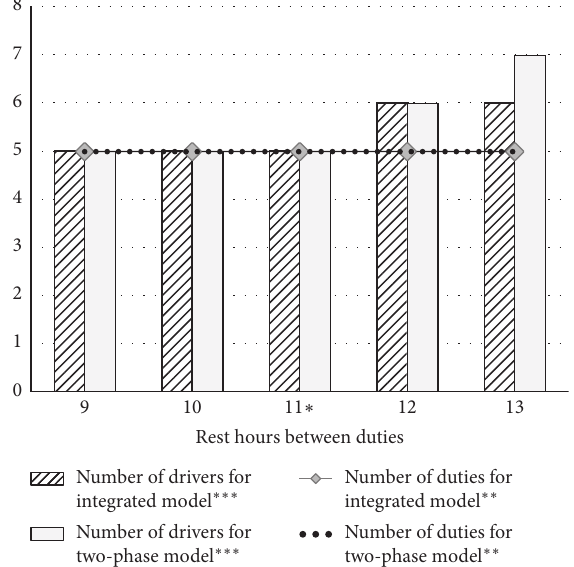
Figure 13: Sensitivity analysis of the rest hours with the integrated and two-phase models. Note . ∗ Current value and comparison basis. ∗∗ The number of duties required to cover the timetable. ∗∗∗ The number of drivers required for the roster.